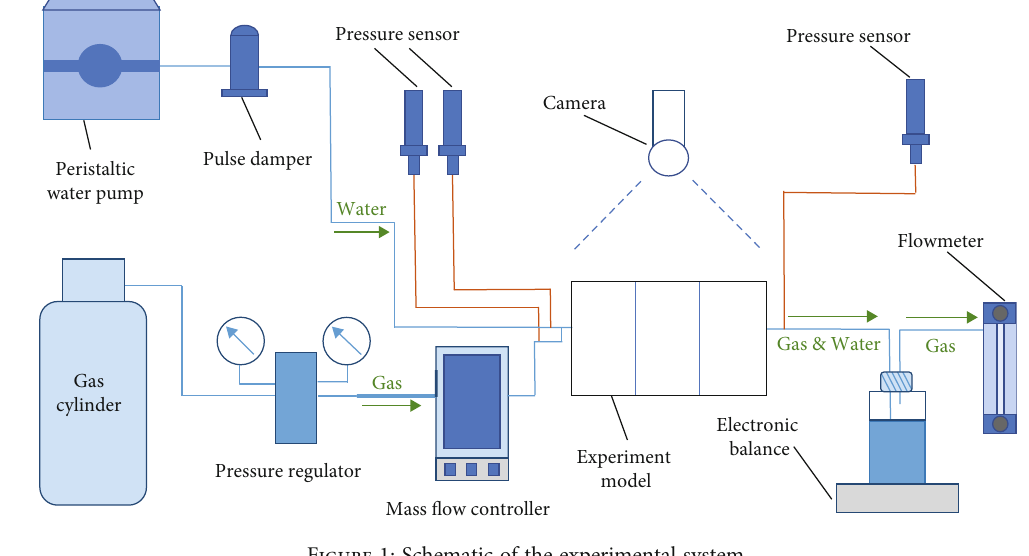
Figure 1: Schematic of the experimental